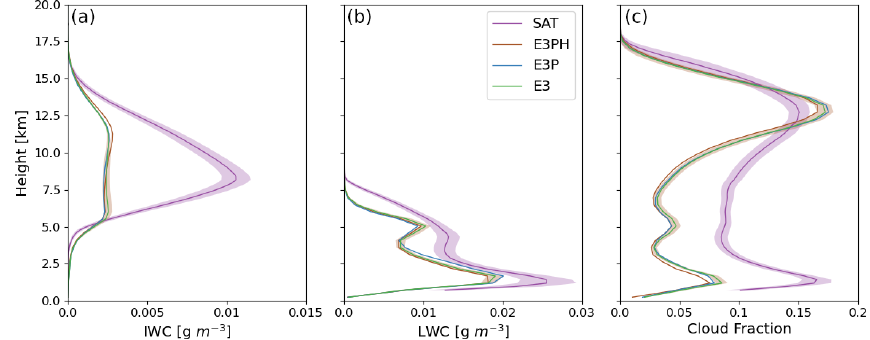
Figure 7. Cloud water content and cloud fraction in EC-Earth3P-HR (E3PH), EC-Earth3P (E3P), EC-Earth3 (E3) and the Cloud- Sat/CALIPSO observations (SAT) averaged over the entire tropics for each height bin. (a) Ice water content (IWC), (b) liquid water content and (c) cloud fraction (CF), for all seasons. Shaded areas show ± 1 σ spread for CloudSat/CALIPSO and EC-Earth3P-HR based on monthly mean values.